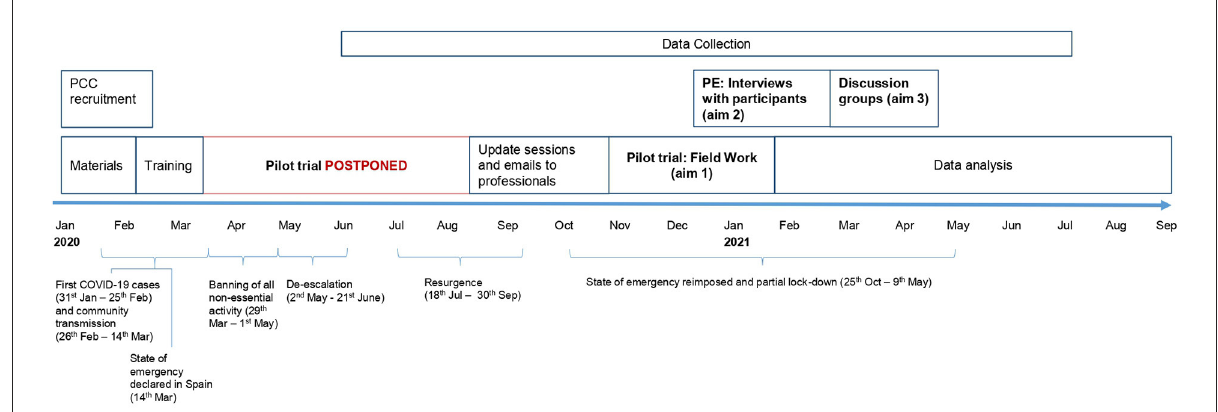
FIGURE1 Timeline of the pilot study and COVID-19 periods in Spain. PCC, primary care center; PE, process evaluation. Aim 1: To test the availability and quality of data used to assess the effectiveness and cost-effectiveness of the IMA intervention. Aim 2: To evaluate the feasibility and acceptability of the IMA intervention in PC. Aim 3: To review the intervention decision aids to ultimately redesign